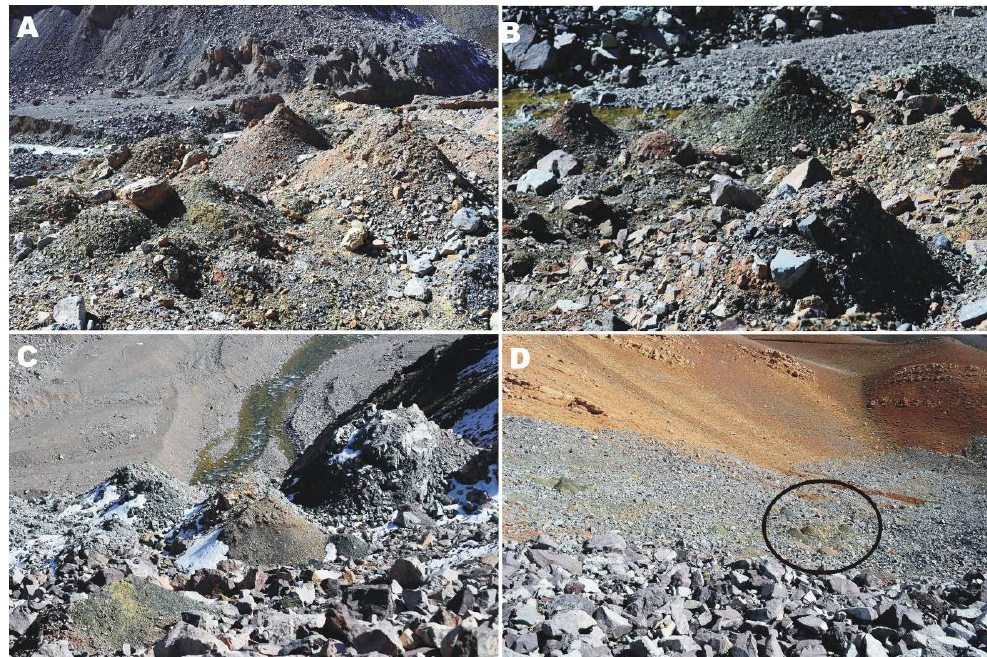
Figure 8. Molards (debris cones) produced by the melting of the ice-cement boulders in the dam. ( A , B ) Molards developed within the evacuating channel, from lagged ice-cemented boulders left by the outburst flood. ( C ) Molards located within the avalanche channel (see details below). ( D ) Molards present over the deflated and thin Flow 2 deposit, that drape the bedrock at the opposite valley margin (distal end).